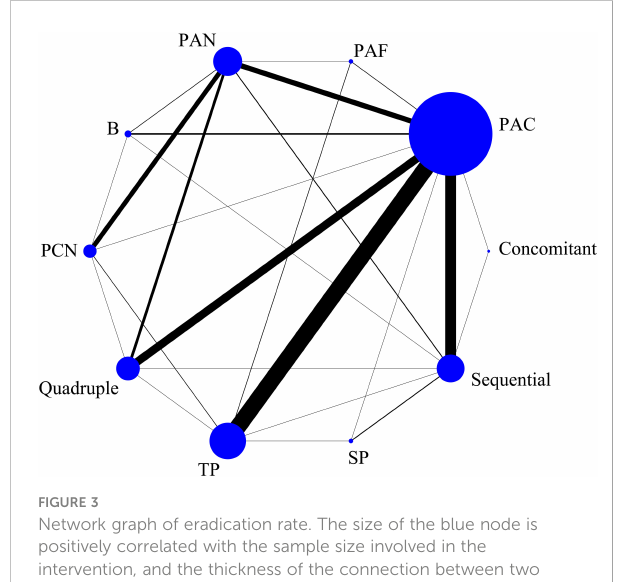
FIGURE 3 Network graph of eradication rate. The size of the blue node is positively correlated with the sample size involved in the intervention, and the thickness of the connection between two nodes represents the number of studies. Regimen labels: B, bismuth-containing triple therapy; Concomitant, concomitant therapy; PAC, PPI, amoxicillin and clindamycin; PAF, PPI, amoxicillin and furanes; PAN, PPI, amoxicillin and nitroimidazoles; PCN, PPI, clindamycin and nitroimidazoles; Quadruple, quadruple therapy; Sequential, sequential therapy; SP, sequential therapy with probiotics; TP, triple therapy with